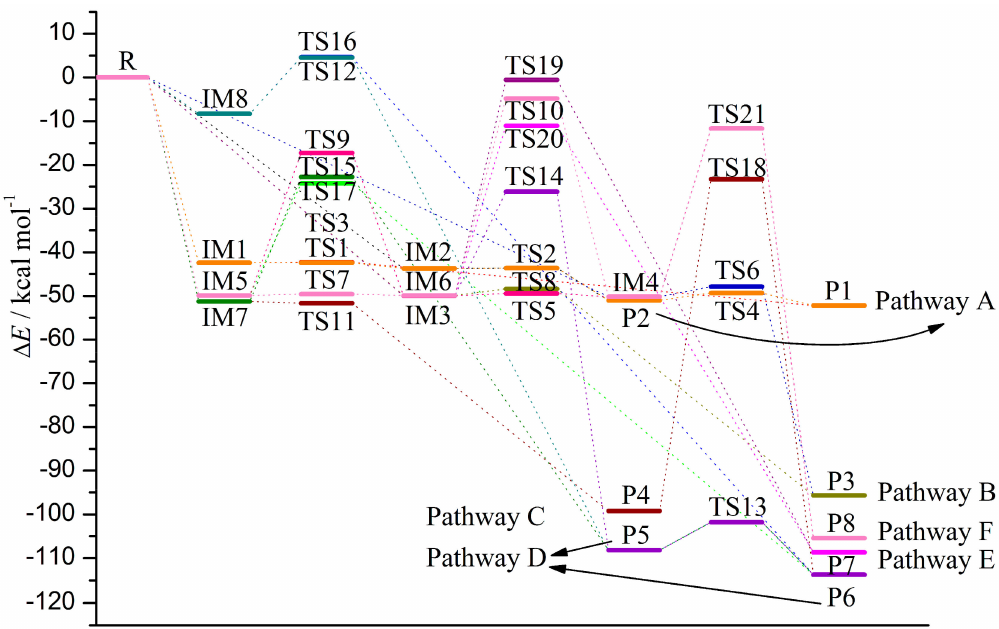
Figure 5. Reaction profiles for the reaction between TCDD and CH